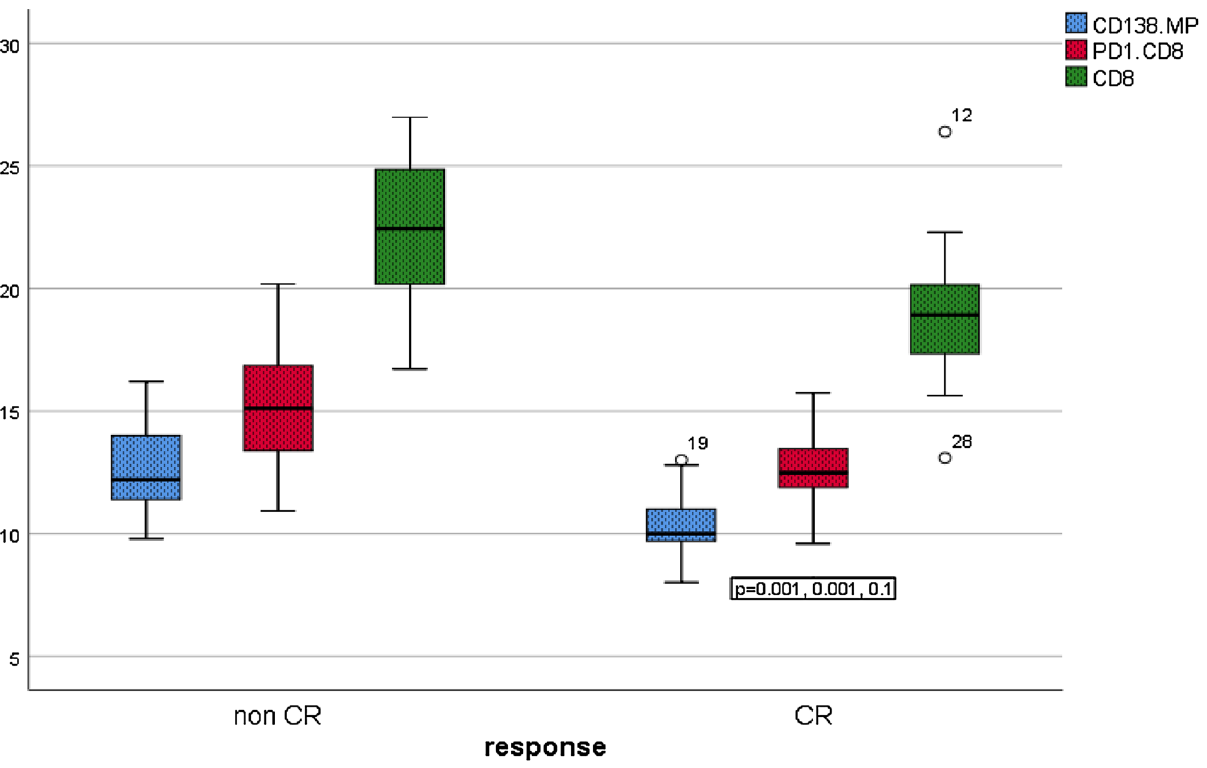
Figure 6. Boxplots showed significant difference between response groups of MM patients regarding CD138MP, PD1+CD8+T, and CD8+T cells. Variable AUC Cut off